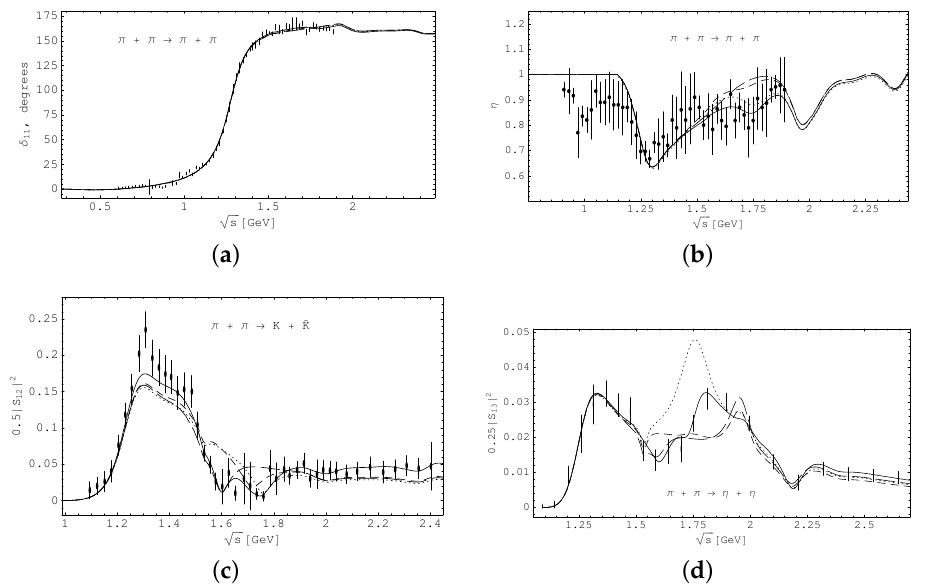
Figure 6. Scattering properties of the ππ → ππ , K ¯ K , ηη processes for four scenarios: (1) full result with inclusion of all relevant f 2 -resonances (solid lines); (2) f 2 ( 1601.5 ) and f 2 ( 1719.8 ) states are excluded (dotted line); (3) f 2 ( 1601.5 ) and f 2 ( 1760 ) states are excluded (short-dashed line); (4) f 2 ( 1760 ) and f 2 ( 1719.8 ) states are excluded (long-dashed line). The experimental data are from Refs. [31,32]. ( a ): Phase shift and in the D -wave ππ -scattering. ( b ): Modulus of the S -matrix element in the D -wave ππ -scattering. ( c ): Squared moduli of the S -matrix element in the D -wave ππ → K ¯ K process. ( d ): Squared moduli of the S -matrix element in the D -wave ππ → ηη